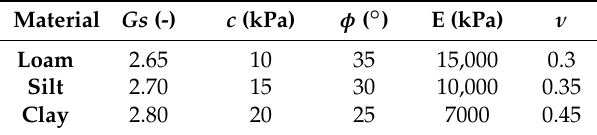
Table 2. Mechanical properties of slope material [51].